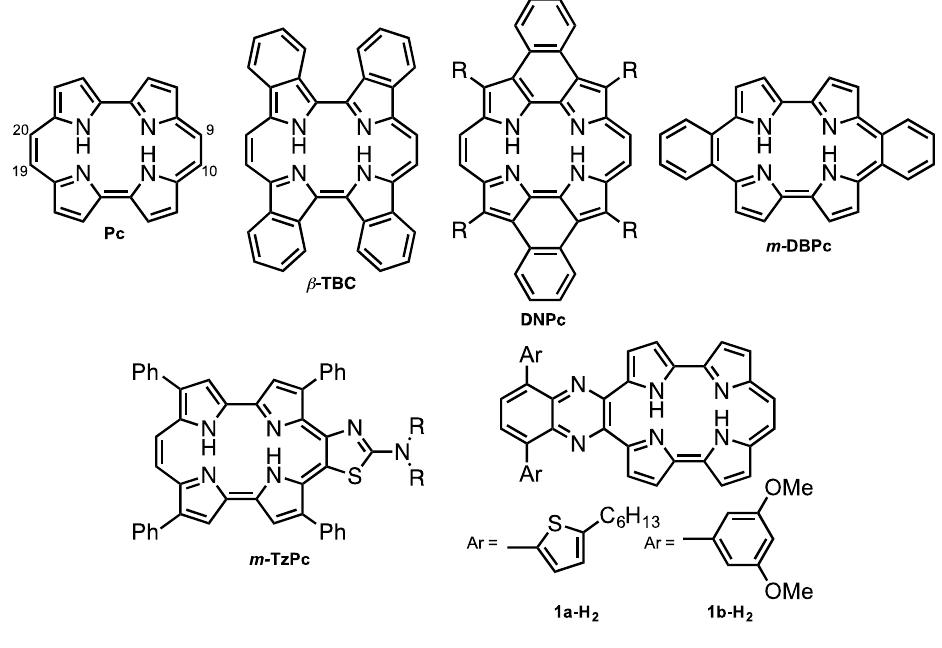
Figure 1. Structures of porphycene ( Pc ) and π -expanded porphycenes.